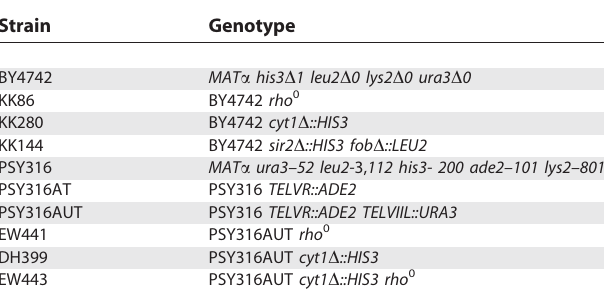
Table 1. Yeast Strains Used in This Study Strain